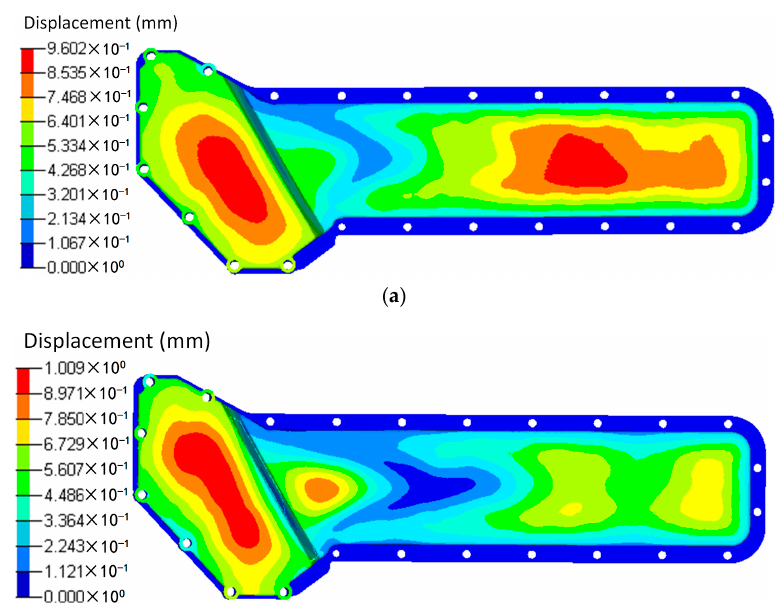
Figure 17. Displacements of ( a ) the isotropic and ( b ) the orthotropic oil cooler covers under distributed pressure and temperature difference.